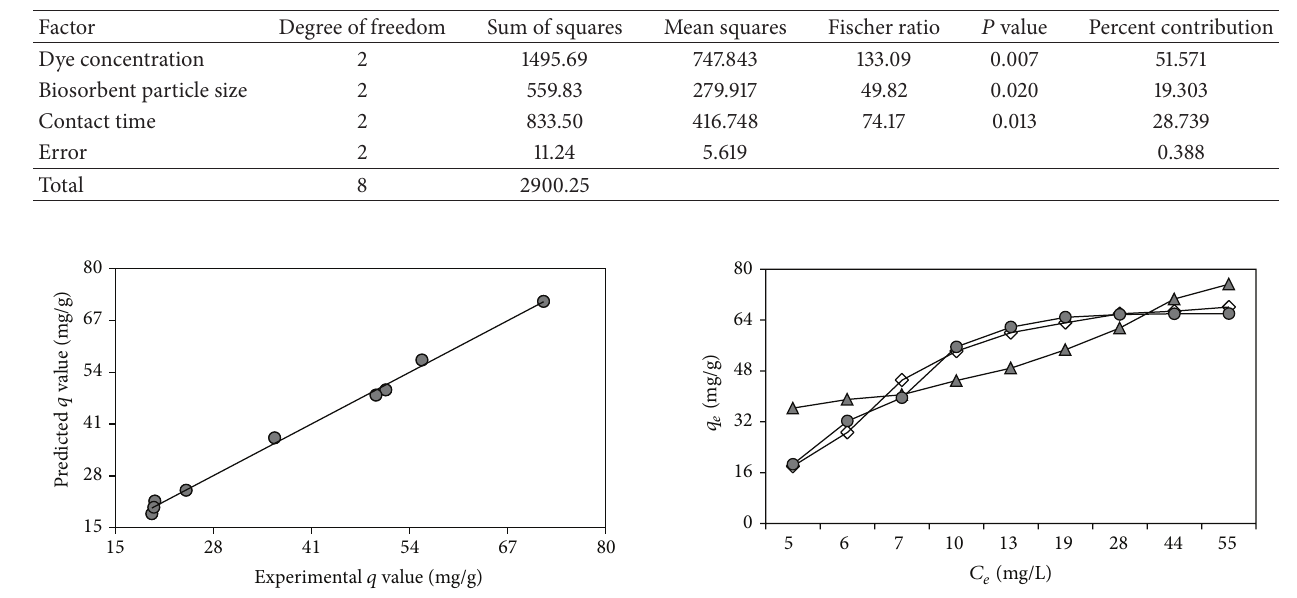
Table 4: Results of analysis of variance (ANOVA).